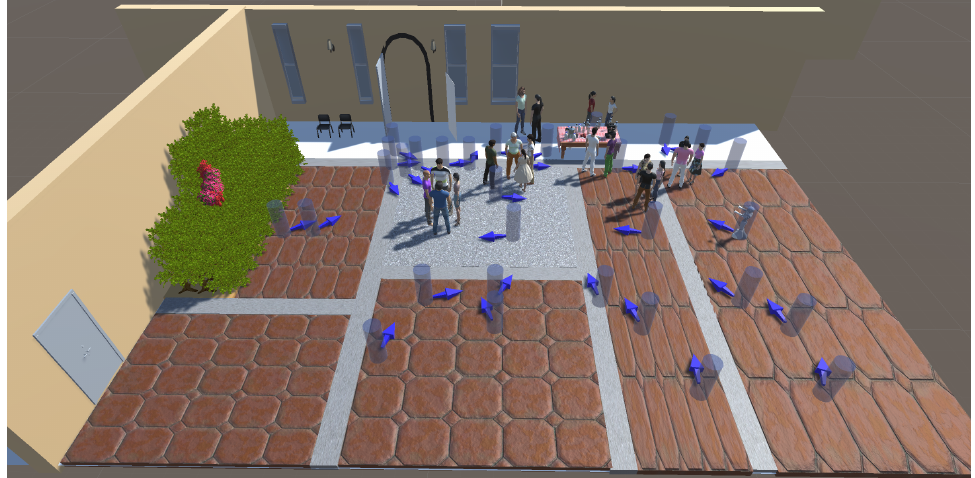
Figure 11. The global view of Scene 1, along with 31 positions for the robot and the robot could be seen in one of the purple cylindrical spaces (best viewed in colour).